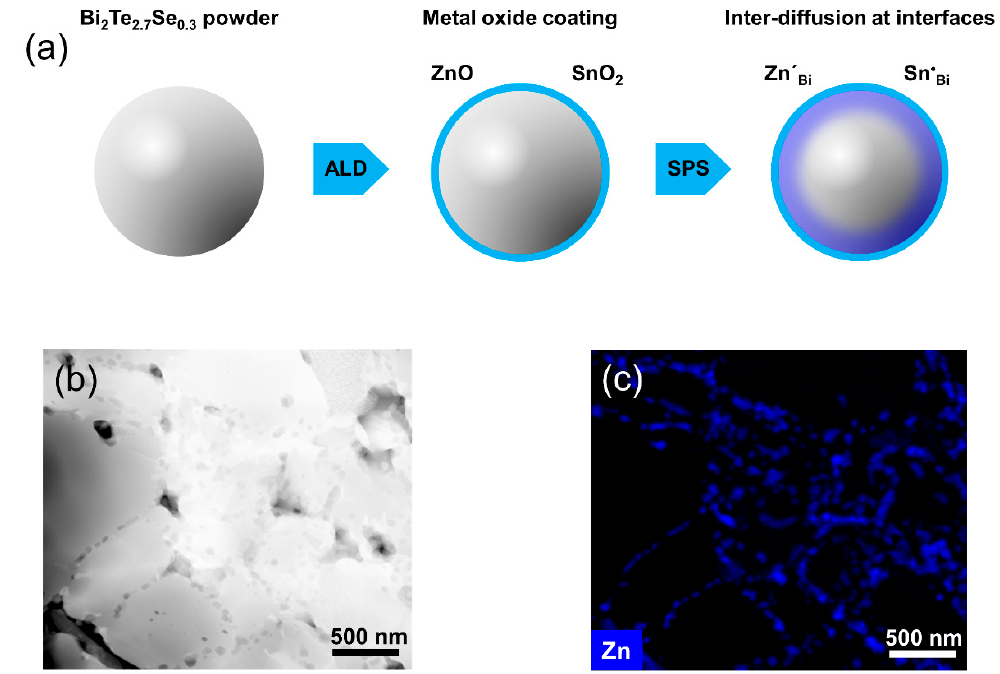
Figure 1. ( a ) Schematic for carrier modulation of Bi 2 Te 3 -based alloys via interfacial doping with atomic layer deposition (ALD); ( b ) high-angle annular dark-field (HAADF) scanning transmission electron microscopy (STEM) image and ( c ) EDS Zn element map of the spark plasma sintering (SPS) pellet of ZnO-coated Bi 2 Te 2.7 Se 0.3 .